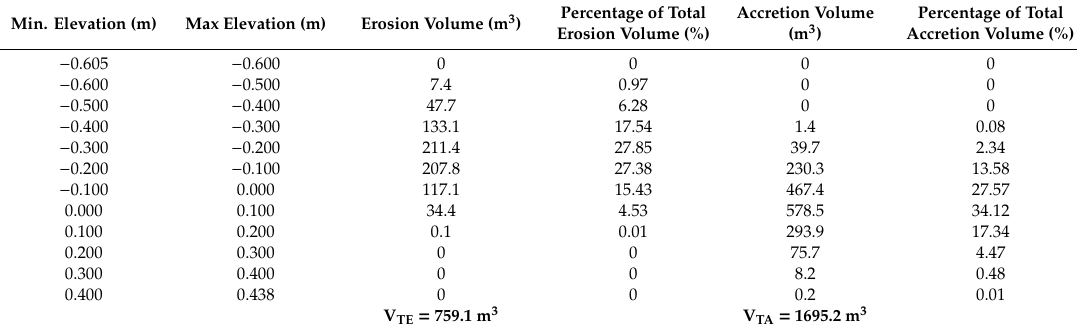
Table 3. Volume changes of the waterbody adjacent to the municipal beach in Gdynia with respect to height di ff erences between the